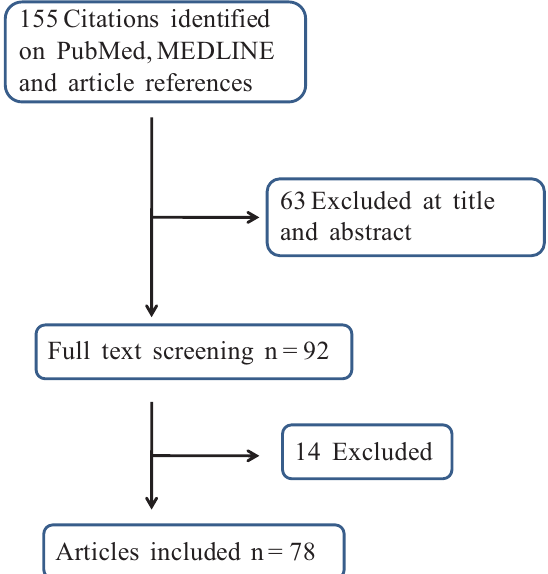
Figure 1. Study selection for inclusion into the